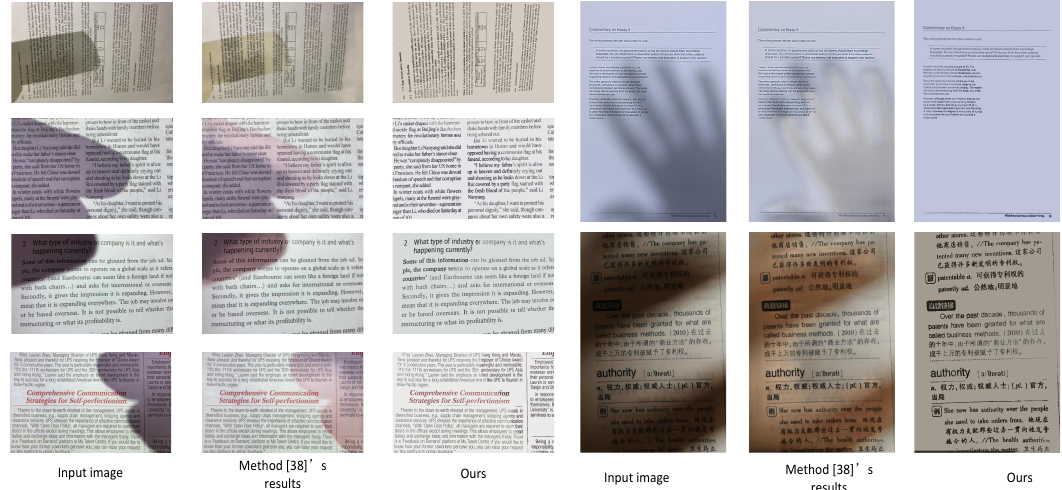
Figure 8. Visual comparison between our method and a CNN model